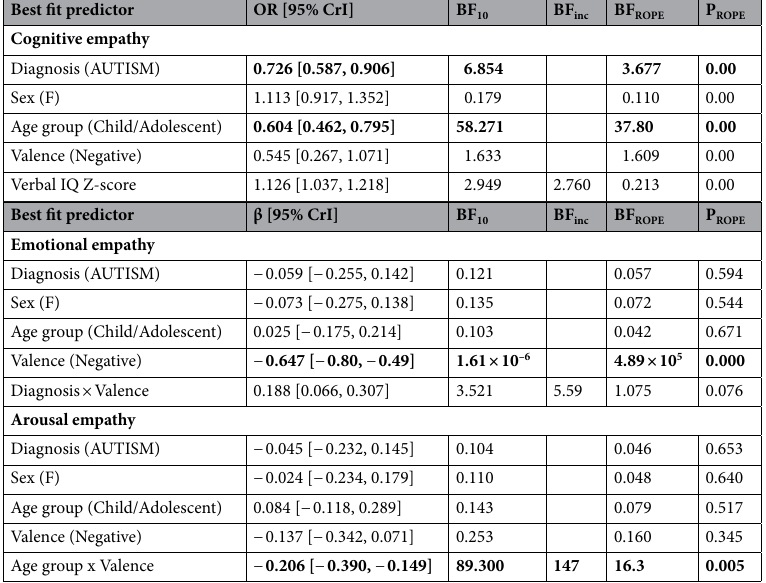
Hierarchical Bayesian models. Model selection procedures indicated that cognitive empathy scores were best predicted by a model including all baseline predictors and VIQ score ( P (cid:31) M BL + VIQ | Data (cid:30) = 0.405 ; R 2 Bayes = 0.257 [0.242, 0.272]). The posterior inclusion probability of VIQ was relatively high ( P VIQ = 0.734), although the inclusion Bayes factor for VIQ did not meet the a priori threshold of 3 ( BF inc = 2.76). Inclusion Bayes factors also provided substantial evidence against the inclusion of all interaction terms, PIQ, and SRS-2 T-score as predictors of cognitive empathy (Table 1). In the best-fitting model, autism diagnosis was associated with a practically significant reduction in per- formance on cognitive empathy (CE) trials (OR = 0.726, 95% CrI [0.587, 0.906], BF ROPE = 3.70). This effect of group on CE is depicted in Fig. 1A. Moreover, age group was an even larger predictor of performance, with children across both diagnostic groups displaying significantly lower emotion recognition accuracy than adults (OR = 0.604 [0.462, 0.795], BF ROPE = 37.80). Neither female sex (OR = 1.113 [0.917, 1.352], BF ROPE = 0.110) or negative valence (OR = 0.545 [0.267, 1.071], BF ROPE = 1.609) significantly predicted performance on the cognitive empathy trials, although there was insufficient evidence to conclude that valence was unrelated to the chance of a correct response. Lastly, although higher VIQ significantly predicted higher performance on cognitive empathy trials (OR = 1.126 [1.037, 1.218] per standard deviation increase in VIQ), there was substantial evidence that this effect was too small to be practically significant ( BF ROPE = 0.213). When predicting emotional empathy, model selection procedures indicated that the most likely model included all baseline predictors as well as the interaction between diagnosis and valence ( P (cid:31) M BL + Dx ∗ Valence | Data (cid:30) = 0.452 ; R 2 Bayes = 0.505 [0.491, 0.518]). Inclusion Bayes factors supported only the inclusion of diagnosis × valence interaction term in the final model ( BF inc = 5.59), along with the exclusion of most other predictors (Table 1). The best-fitting model displayed a large effect of valence, with lower reports of shared feelings for negative emotions (β = − 0.647 [− 0.800, − 0.489], BF ROPE = 4.89 × 10 5 ), as well as small and practically insignificant main effects of diagnostic group (β = − 0.059 [− 0.255, 0.142], BF ROPE = 0.057), sex (β = − 0.073 [− 0.275, 0.138], BF ROPE = 0.072), and age group (β = 0.025 [− 0.175, 0.214], BF ROPE = 0.042). The inter- action between diagnosis and valence was statistically significant, although the ROPE Bayes factor was equivocal with regard to its practical significance (β = 0.188 [0.066, 0.307], BF ROPE = 1.075). Although both diagnostic groups reported empathizing more with positive than negative emotions, this difference was larger in the NT group ( d = 0.647 [0.489, 0.800]) than the autism group ( d = 0.459 [0.315, 0.614]). This interaction is depicted in Fig. 1B. When predicting ratings of arousal, the best-fitting model was found to include all baseline predictors as well as the interaction between age group and valence ( P (cid:31) M BL + Age ∗ Valence | Data (cid:30) = 0.677 ; R 2 Bayes = 0.466 [0.451, 0.480]). Inclusion Bayes factors demonstrated strong support for the inclusion of the age group × valence interac- tion ( BF inc = 147), as well as the exclusion of all other potential predictors (Table 1). Coefficients in the best-fitting model indicated practically insignificant effects of autism diagnosis (β = − 0.045 [− 0.232, 0.145], BF ROPE = 0.046),